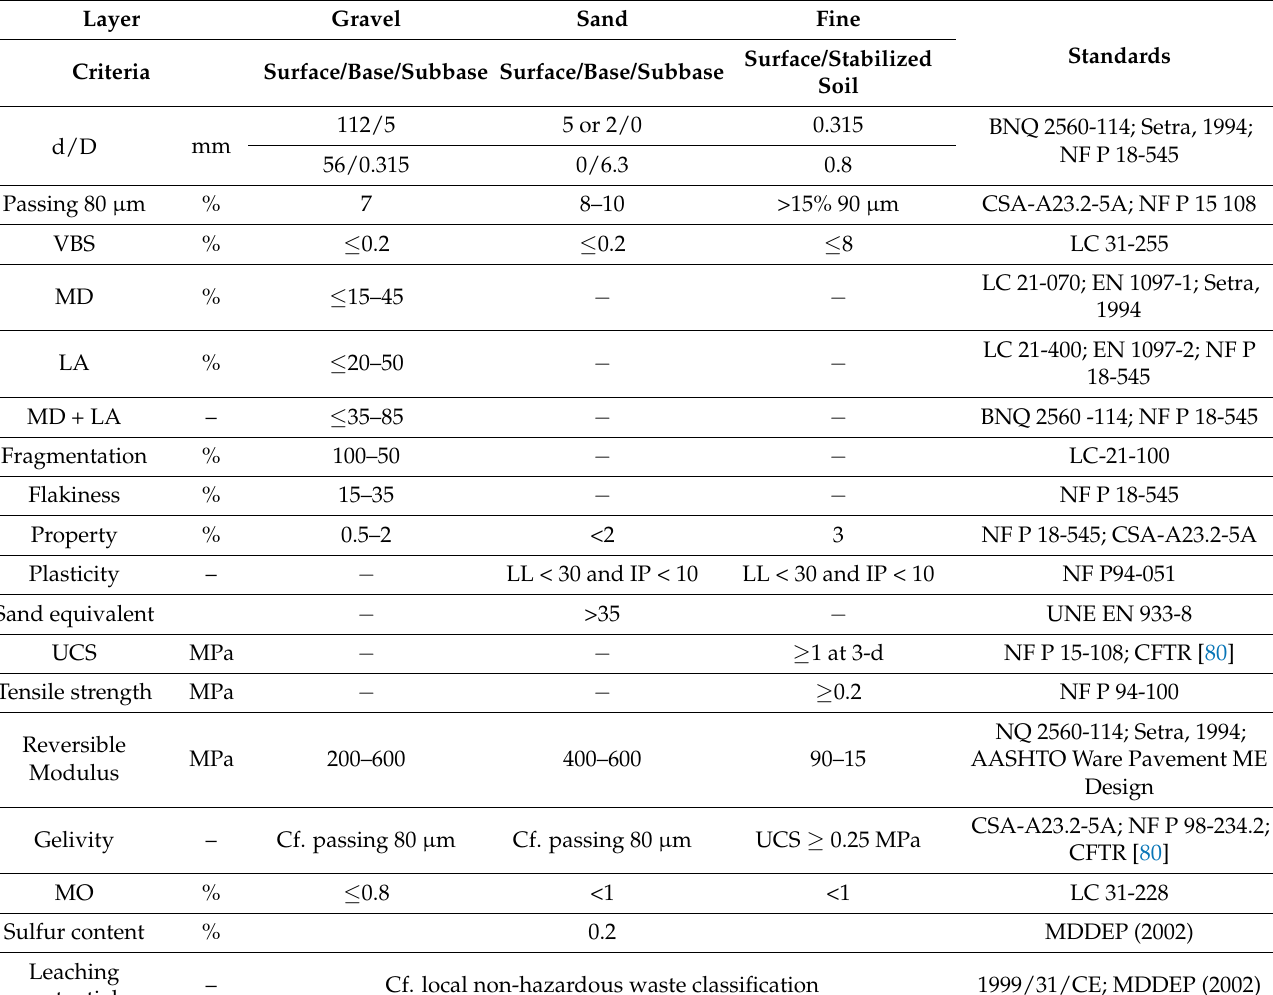
Figure 3. Aggregate selection assessment framework for use as a base or subbase adapted [79]. Table 6. Specifications for materials used for the base, subbase, subgrade, and asphalt surface.